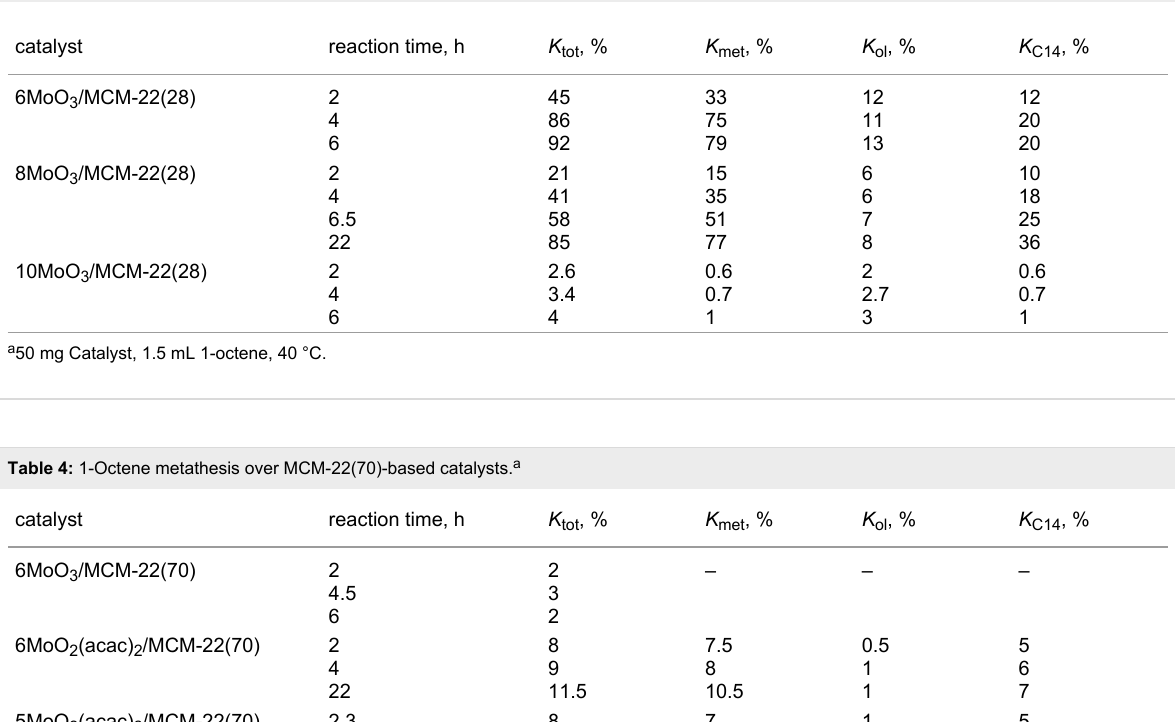
Table 3: The effect of Mo loading on catalyst activity in 1-octene metathesis. a